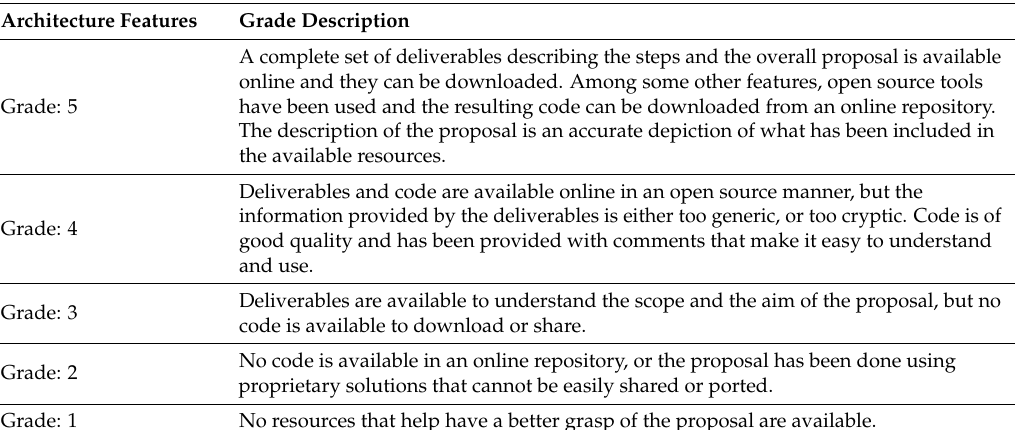
Table 10. Information availability